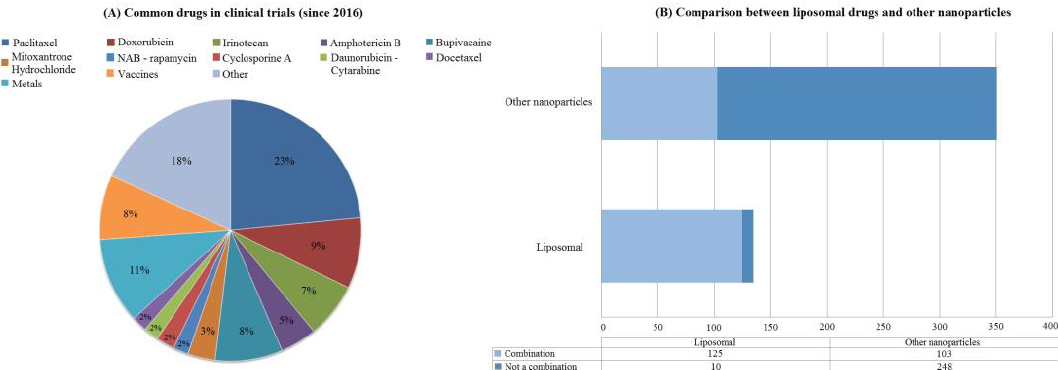
Figure 3. Common drugs and liposomal drugs application. The categories in ( A ) were formed based on the most common studied drugs. Mostly, each drug was mentioned individually except for the groups metals, vaccine and other. The first two groups were formed based on the heterogeneity of the drugs they comprise. The vaccine group most often consisted of mRNA vaccines, while the Metals group was dominated by various iron preparations. Others consisted of drugs that occurred no more than two times in the entire excerpt. Paclitaxel consisted of various nanoparticle types that were loaded with paclitaxel. Among them, NAB-paclitaxel was occurring the most often (57 trials out of 62 trials for paclitaxel in total). Chemotherapy drugs in general were the most common drugs in the dataset (paclitaxel—23%, doxorubicin—9%, irinotecan—7%). Different vaccines and metals were also often mentioned in clinical trials (8% and 11% respectively). Local anesthetic bupivacaine was also frequently incorporated in nanoparticle systems (8%). Obtained results could be explained by various properties that nanoparticles can have as drug carriers (for instance, site-specific drug delivery). ( B ) shows the division of clinical trials that studied liposomal drugs either individually or in combination with other regular drugs. Based on ( B ), liposomal drugs were primarily used in combination with other drugs (125 clinical trials with combinations out of a total of 135 liposomal trials). Such a phenomenon can be explained by a small amount of liposomal clinical trials in comparison with all the other types of nanoparticles. The second possible reason can be due to specific diseases (for instance, neoplasms) that require a combination of therapeutic agents